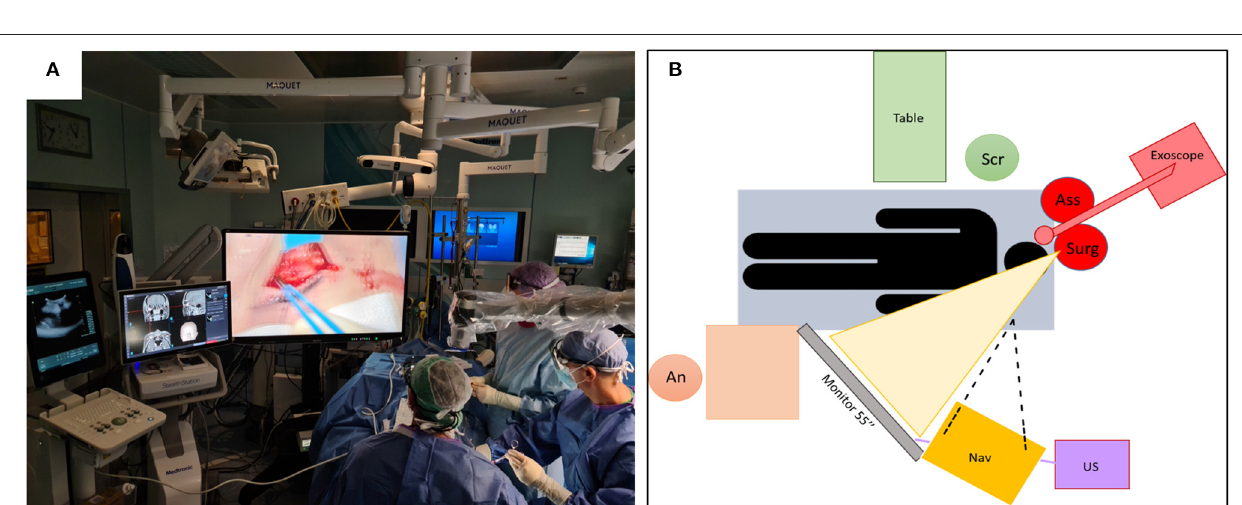
FIGURE 3 | Summary of the main surgical steps. Skin incision of the lower eyelid (A) ; localization of the hemangioma before the opening of the periorbit using navigation (B) ; localization of the hemangioma within the periorbit using ultrasound (C) ; blunt dissection and removal of the hemangioma (D) .